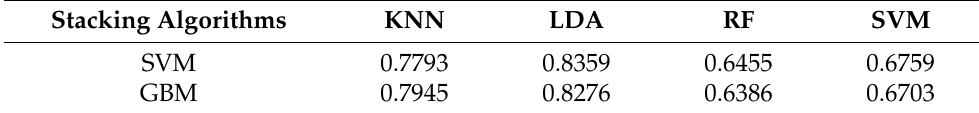
Table 9. Accuracy values of stacking algorithms for the bedroom